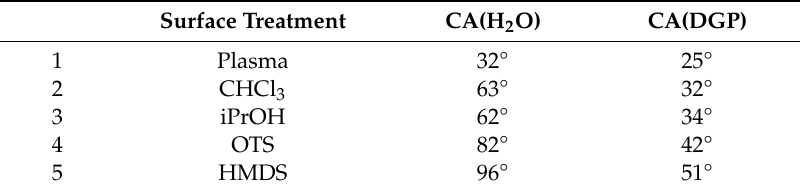
Table 1. Summary of H 2 O and DGP contact angles (CA) for different surface treatments Si / SiO 2